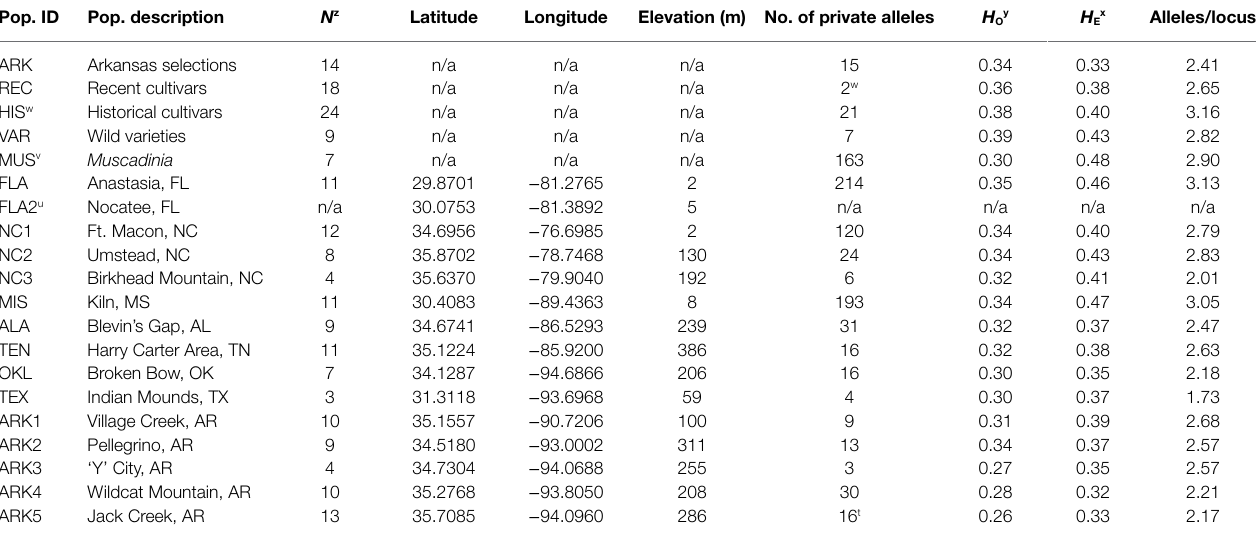
TABLE 1 | Population names, number of individuals per population, locational data for each population, and summary statistics for basic population genetics parameters. Pop. ID Pop.